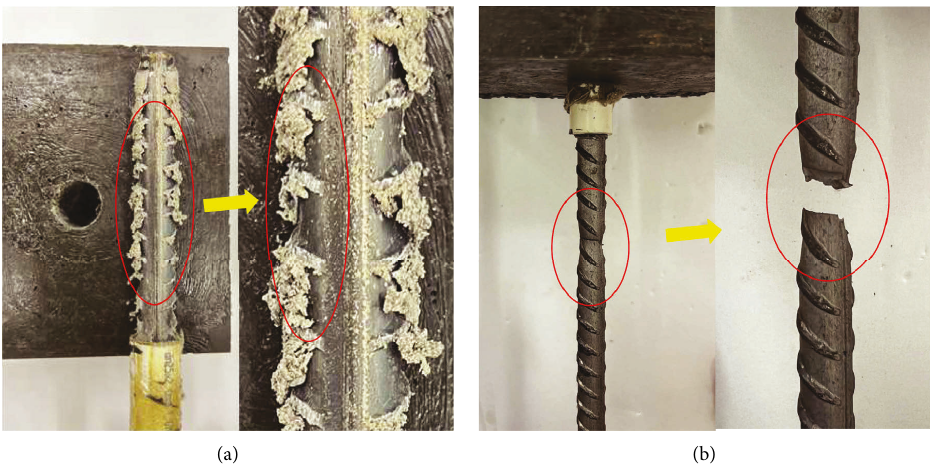
Figure 32: Typical damage patterns of reinforcement pull-out